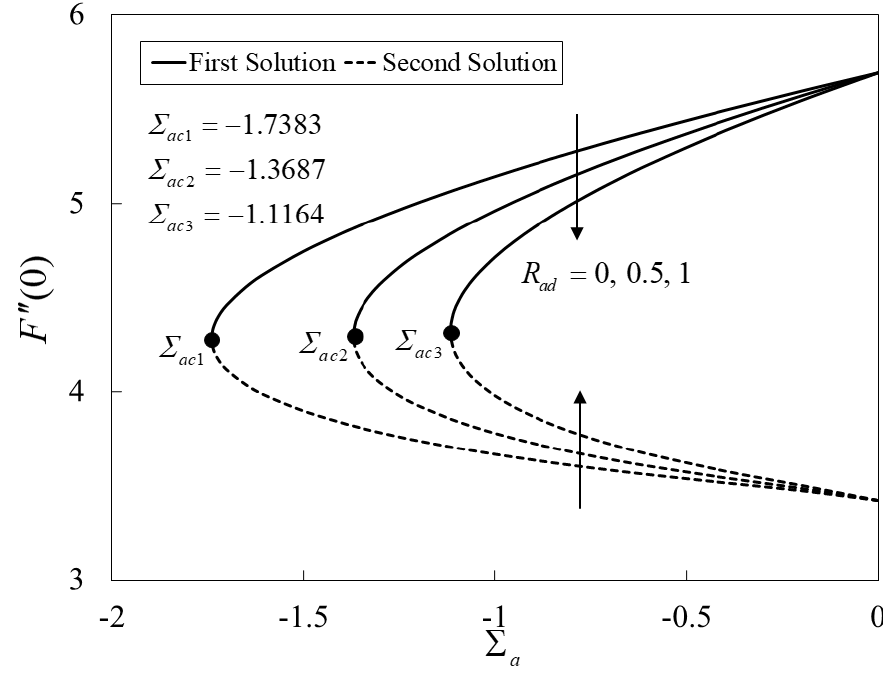
Figure 5. Variation in the skin friction coefficient F (cid:48)(cid:48) ( 0 ) with Σ a for different values of R ad .